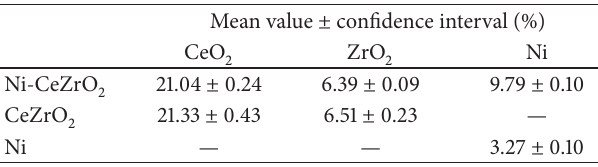
Table 5: Content of CeO 2 , ZrO 2 , and Ni in the examined materials ( 𝑛 = 12 ). The remaining content is assumed to be